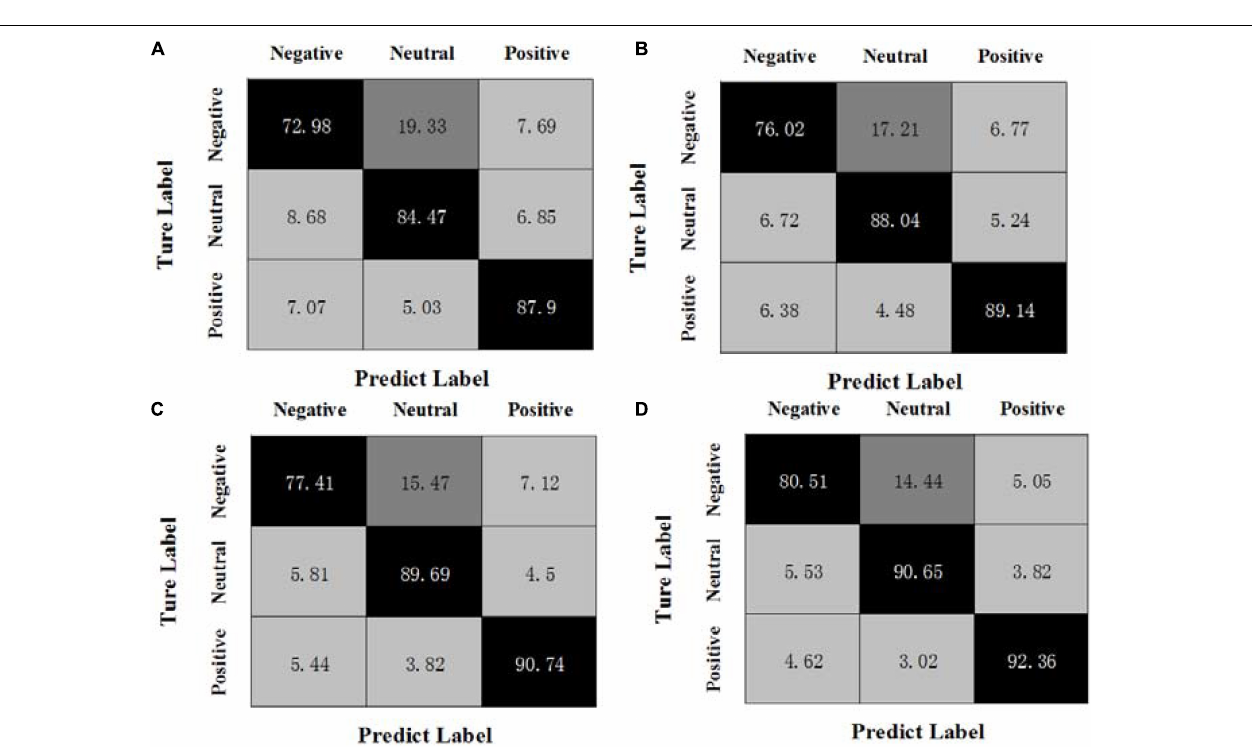
FIGURE 2 | Confusion matrices of OPFDDL on the SEED dataset, (A) β + γ , (B) α + β + γ , (C) θ + α + β + γ , (D) δ + θ + α + β + γ .